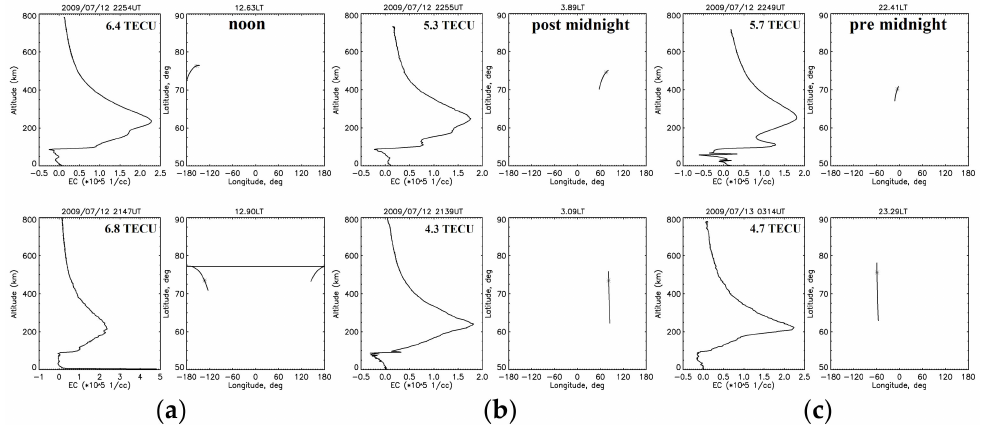
Figure 7. Height profiles of electron density (EC) measured by the GPS RO technique in the mission FORMOSAT-3/COSMIC at high latitudes during the jet disturbed time from 2243 to 2255 UT (upper panels) and during quiet time (lower panels) in different local time sectors: ( a ) noon; ( b ) post- midnight; ( c ) pre-midnight. Each panel shows the EC height profile (left) and the trajectory of the perigee of the RO trace (right). Asterisc indicates the EC maximum location. The total electron content is indicated for each profile in